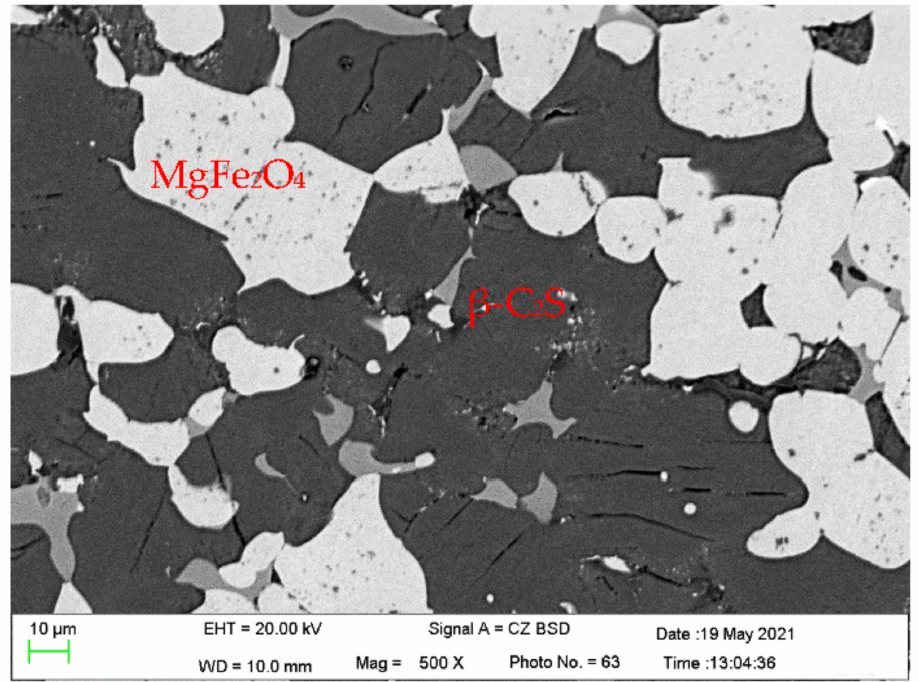
Figure 6. Scanning electron microscope photograph of oxidized BOF